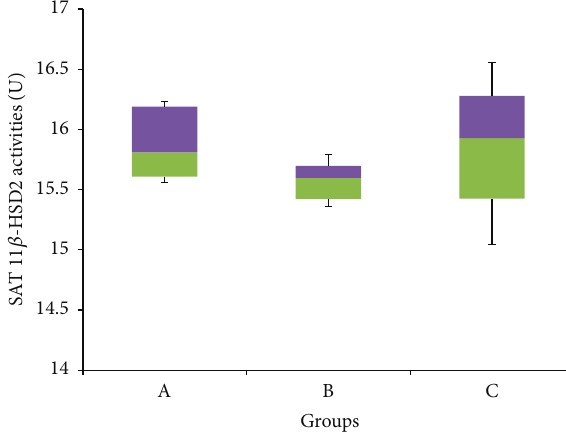
Figure 12: 11 𝛽 -HSD 2 activities in the subcutaneous adipose tissue of rats in groups A, B, and C at the end of the four-week treatment period. Group A: control (HSD/HFD); group B: stress + HSD/HFD; group C: stress + GA + HSD/HFD. Abbreviations: GA: glycyrrhizic acid, HSD: high-sucrose diet, and HFD: high-fat